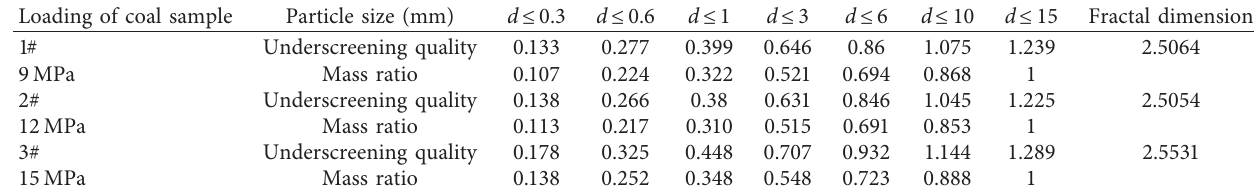
Table 4: The gradation and fractal dimension under special axial